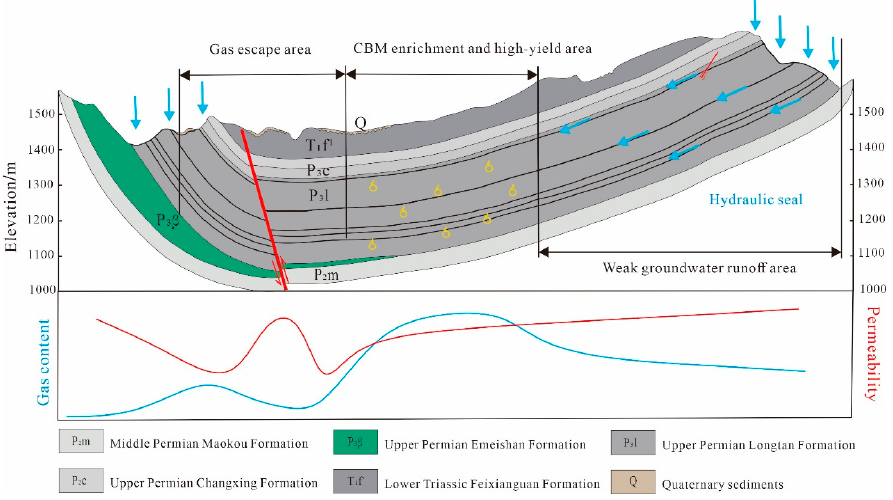
Figure 8. High rank coal CBM enrichment and high-yield model in